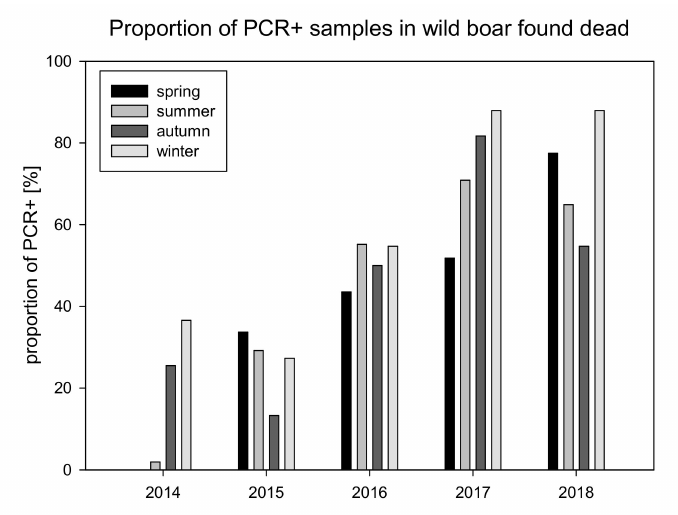
Figure 5. Proportion of PCR positive samples in found dead wild boar sorted by seasons (winter = December to February; spring = March to May; summer = June to August; autumn = September to November).